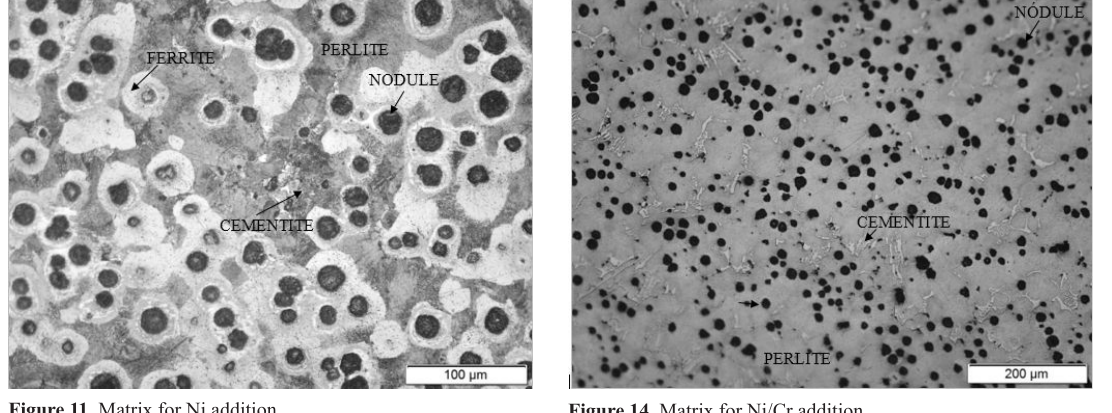
Figure 14. Matrix for Ni/Cr addition.